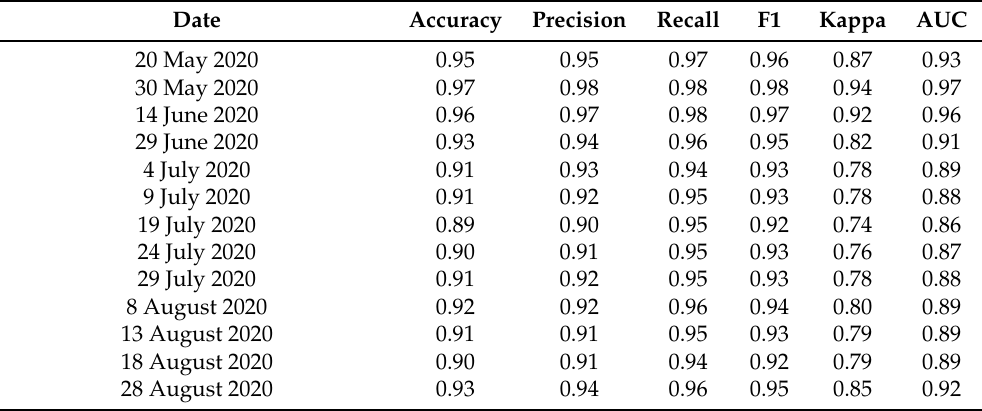
Table 5. CLAML-M metrics